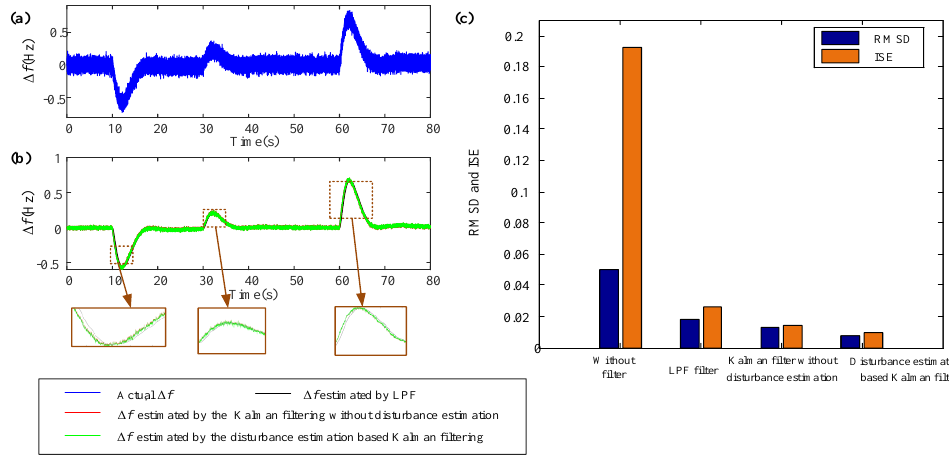
Figure 8. ∆ f estimated by the four methods: ( a ) ∆ f with measurement noise; ( b ) ∆ f estimated by the Figure 8. Δ f estimated by the four methods: ( a ) Δ f with measurement noise; ( b ) Δ f estimated by the four methods; ( c ) RMSD and ISE of the four four methods; ( c ) RMSD and ISE of the four methods.